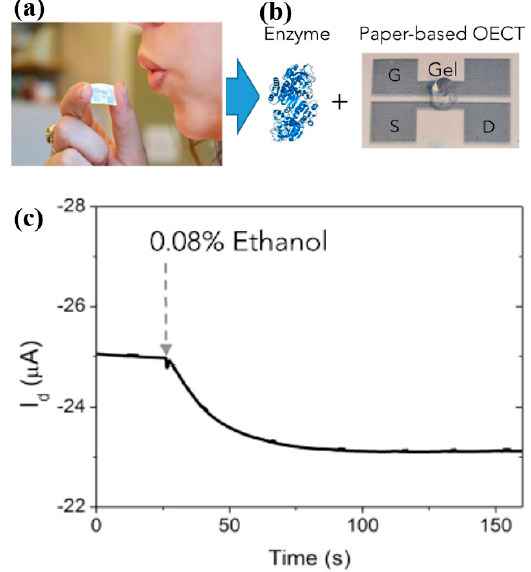
Figure 11. Concept of the organic electrochemical transistor (OECT) breathalyzer. ( a ) Simply breathing on the printed PEDOT–PSS OECT allows for alcohol detection. ( b ) The alcohol dehydrogenase (ADH) enzyme and the OECT are the key components of the sensor. The OECT is printed on paper, and comprises channel, source (S), drain (D), and gate (G) electrodes made of PEDOT–PSS; the enzyme electrolyte gel is deposited onto the OECT bridging the channel and gate. ( c ) I d response of the OECT upon exposure to ethanol [42] (reproduced with permission).